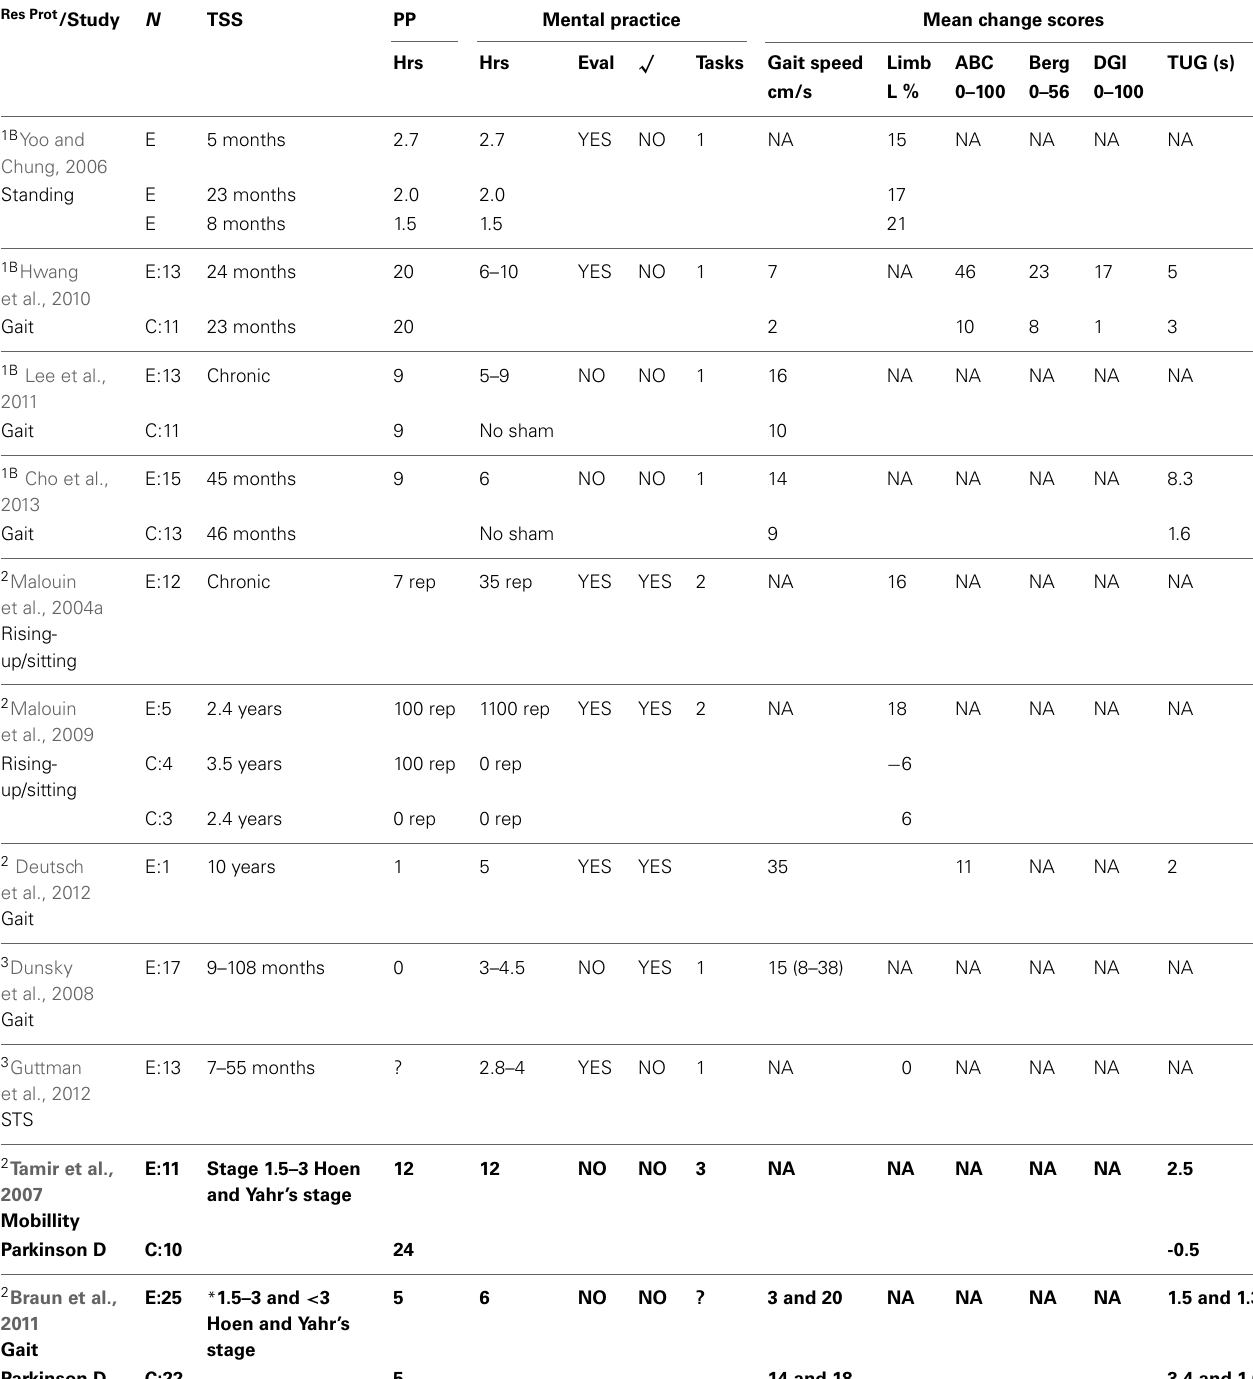
Table 4 | Characteristics of MI training studies for mobility and locomotor activities. Res Prot /Study